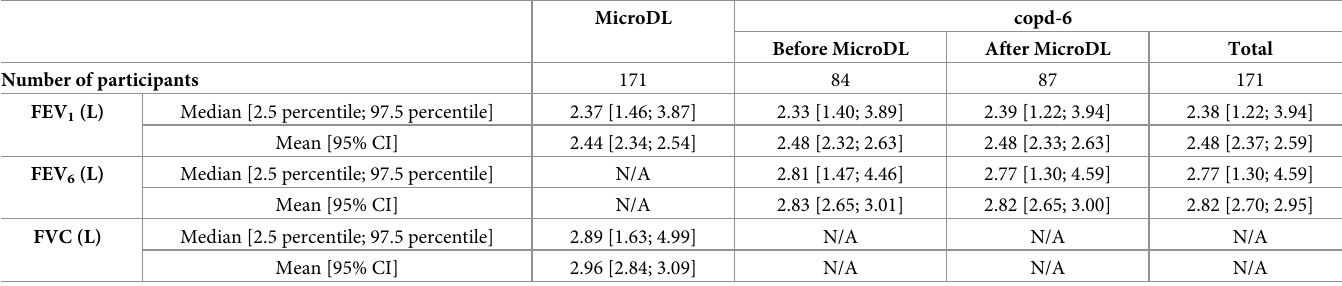
Table 2. Summary metrics for results from MicroDL and copd-6 spirometers.